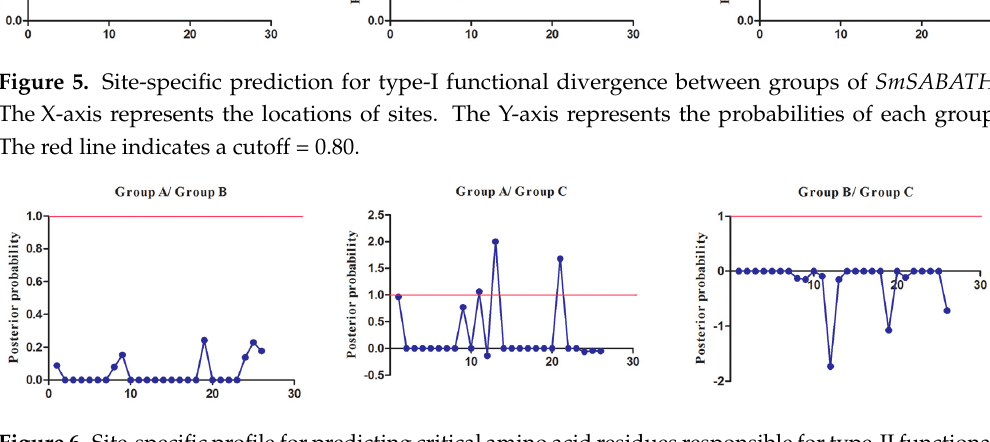
Figure 6. Site-specific profile for predicting critical amino acid residues responsible for type-II functional divergence between groups of SmSABATH . The X-axis represents the locations of sites. The Y-axis represents the probabilities of each group. The red line indicates a cutoff = 1.0.